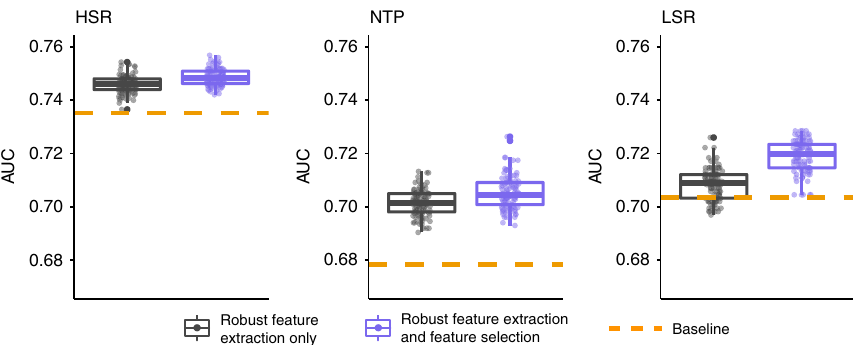
Fig. 4 Applying unsupervised Laplacian score features selection to VoPo features. Unsupervised feature selection was applied independently to the frequency-based features engineered from each metaclustering solution. Here, we show distributions of classi fi cation accuracies (AUC) with (purple boxplots) and without (gray boxplots) feature selection applied to features extracted with VoPo. The dashed orange horizontal line shows the mean baseline classi fi cation accuracy using the features obtained without the use of the VoPo pipeline. In all three datasets VoPo ’ s robust feature extraction (gray) improved the results over baseline (orange boxplots). Additionally, VoPo ’ s robust feature selection followed by unsupervised feature selection further improved classi fi cation accuracy (purple boxplots). The boxplots show median values, interquartile range, whiskers of 1.5 times interquartile range, and all individual